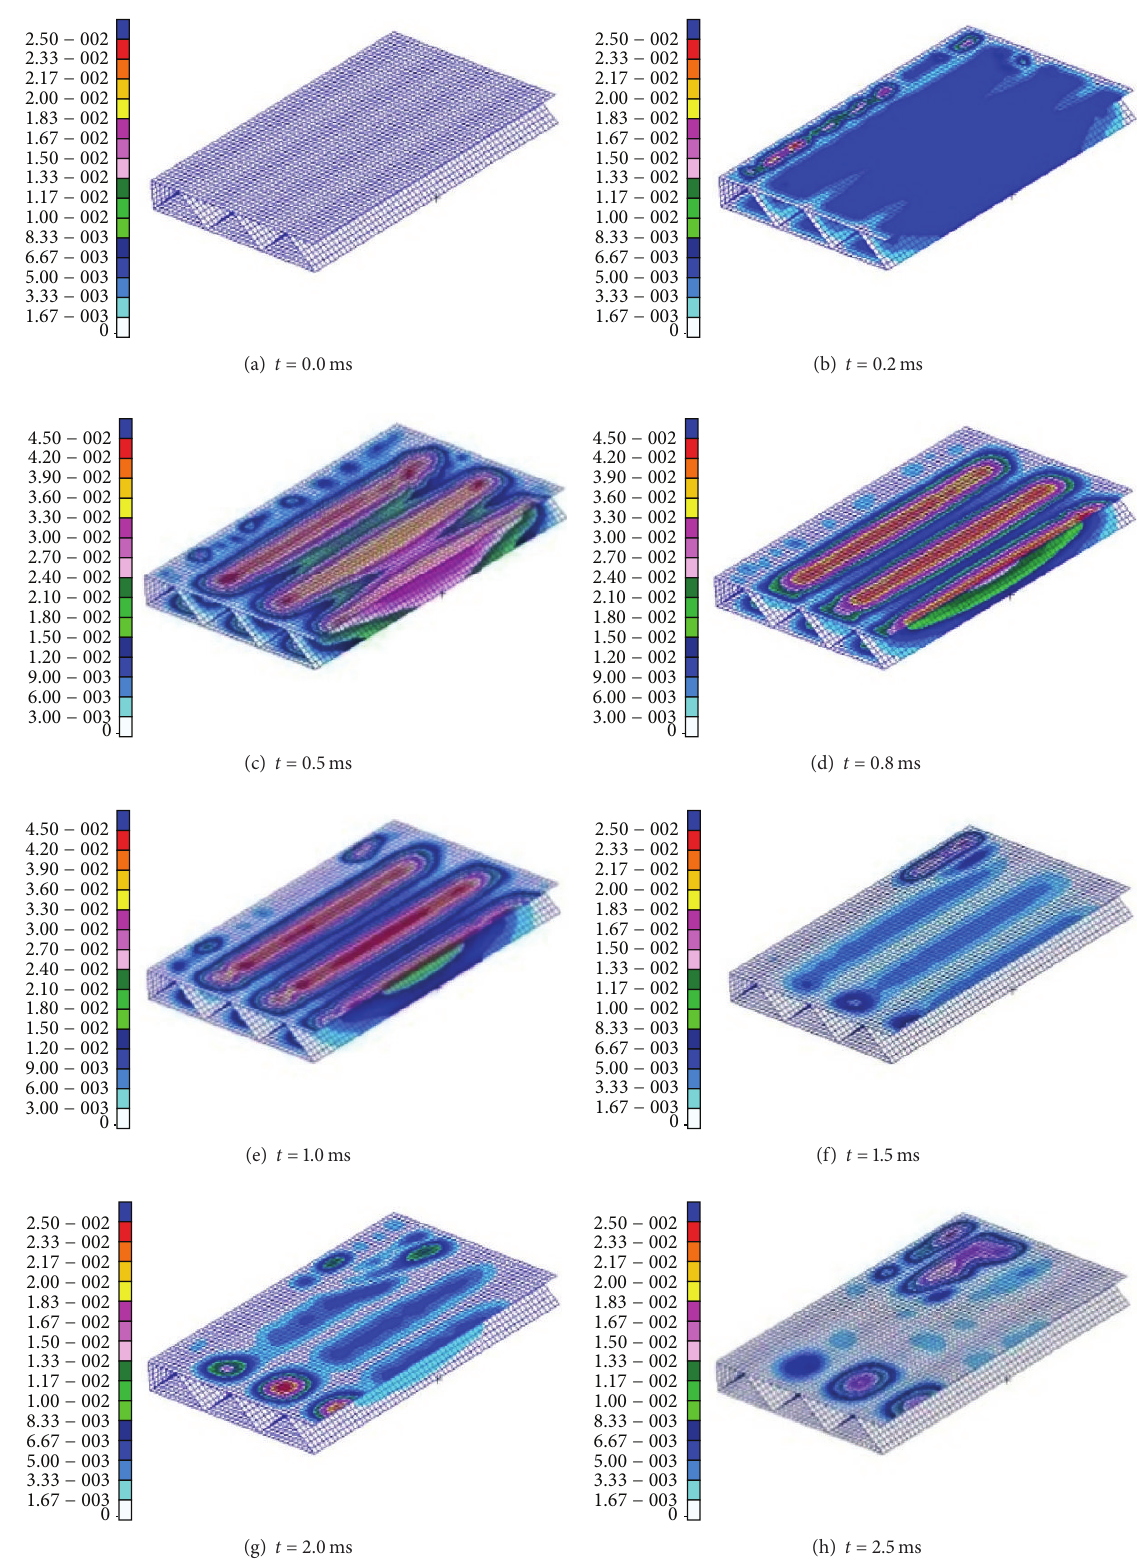
Figure 17: Deformation of case 1 ( W = 0.05 kg, d = 0.6